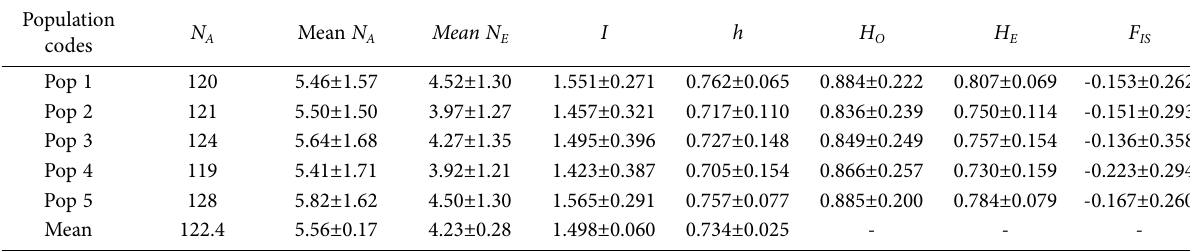
Table 4 Genetic diversity of R. simsii populations at different